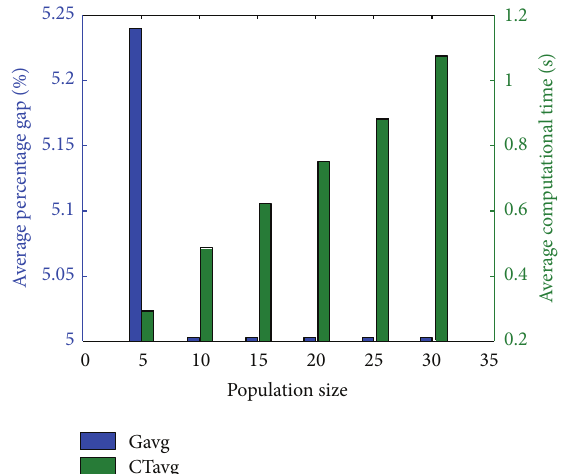
Figure 6: The effect of the value of 𝛼 with respect to relative computational time and average percentage